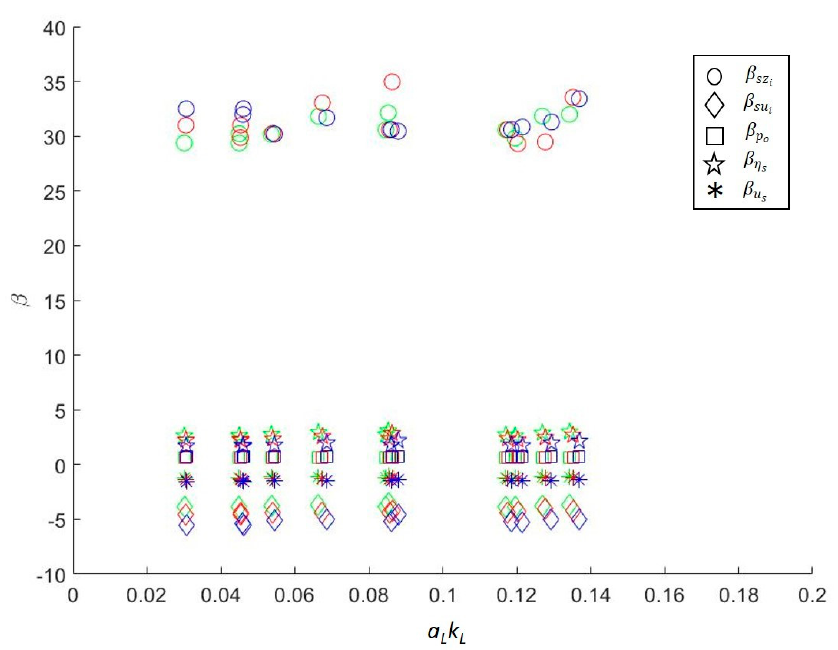
Figure 9. Contributions to the growth rate coefficient, β , for all irregular wave cases. Green, red and blue symbols represent U = 7 m/s, U = 8.5 m/s and U = 10 m/s, respectively.